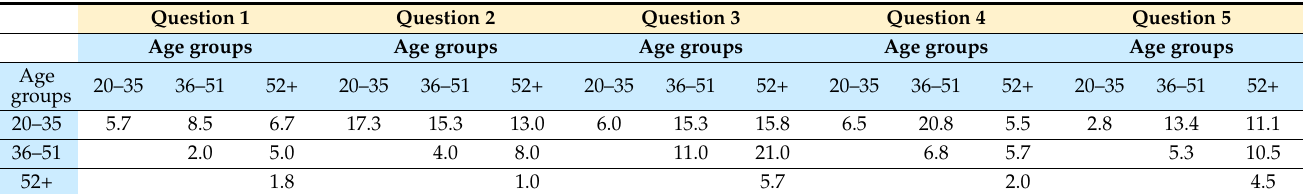
Table 2. Sums of Jaccard similarity indices J u,v (for ages u and v ) per question Q k for all responses, all subthemes, and all three age groups, per question.